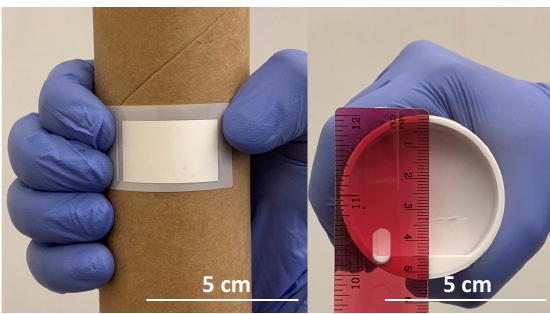
Figure 2. Flexibility test on a printed pattern.